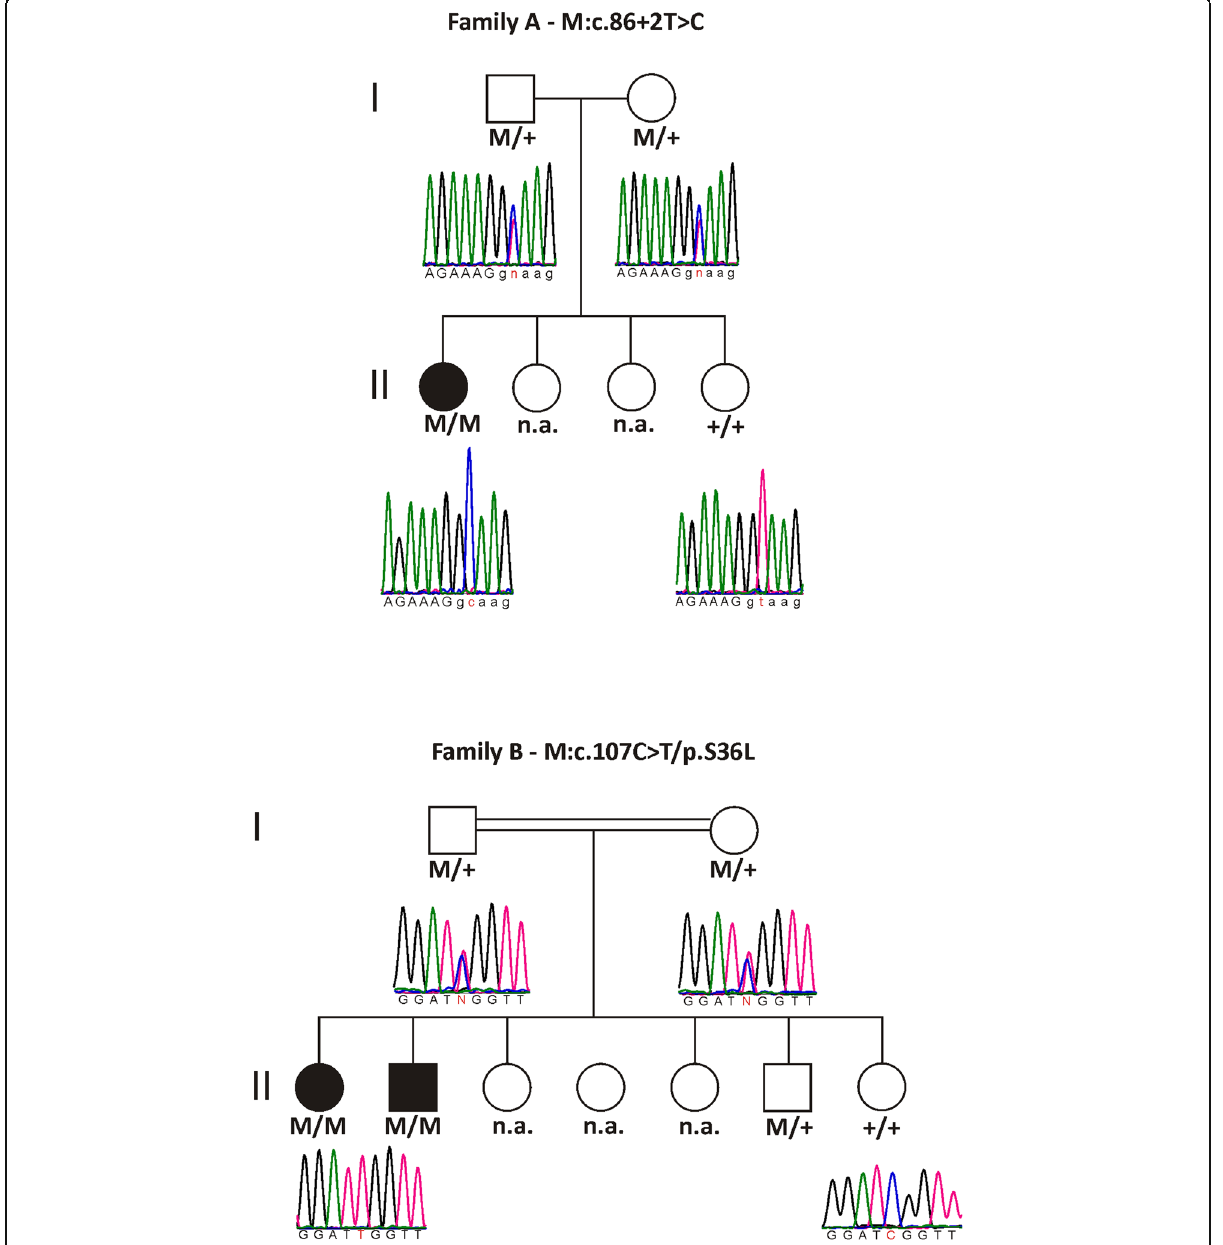
Fig. 1 Pedigrees of families A and B. Genotypes and sequence profiles are given below each available family member. Exonic sequences are given in capital letters and intronic sequences in small letters, respectively. The nucleotides that are changed are highlighted in red. M, mutant allele; +, wildtype allele; n.a., not